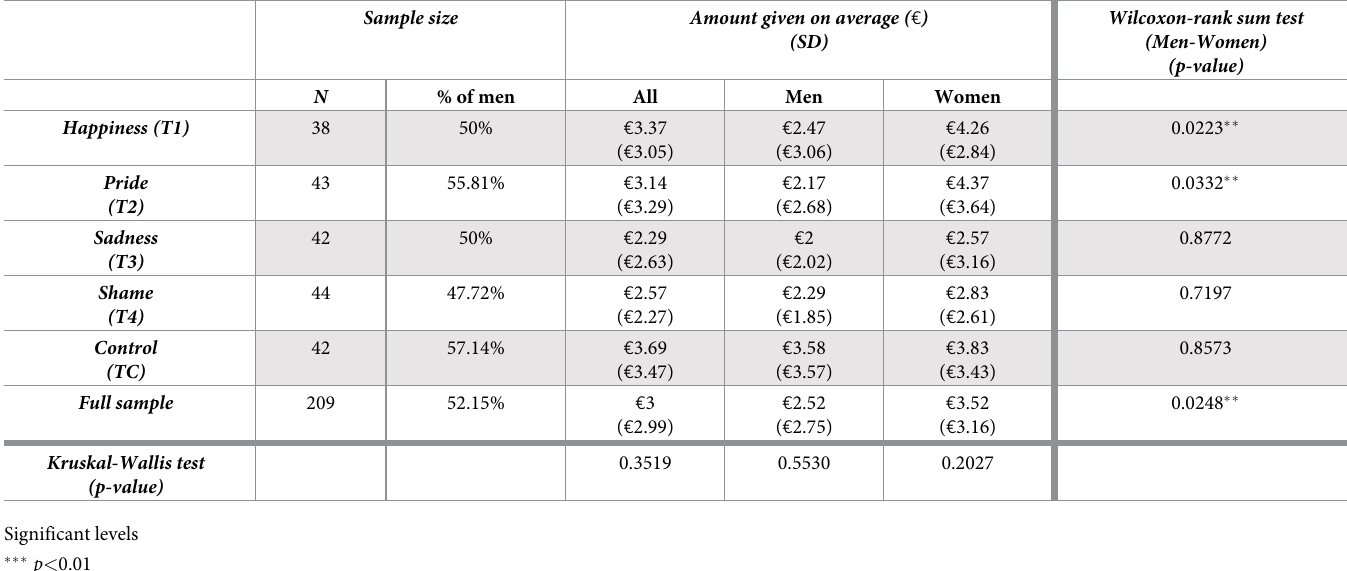
Table 5. Donation decisions and gender effect (by treatment and full sample). Sample